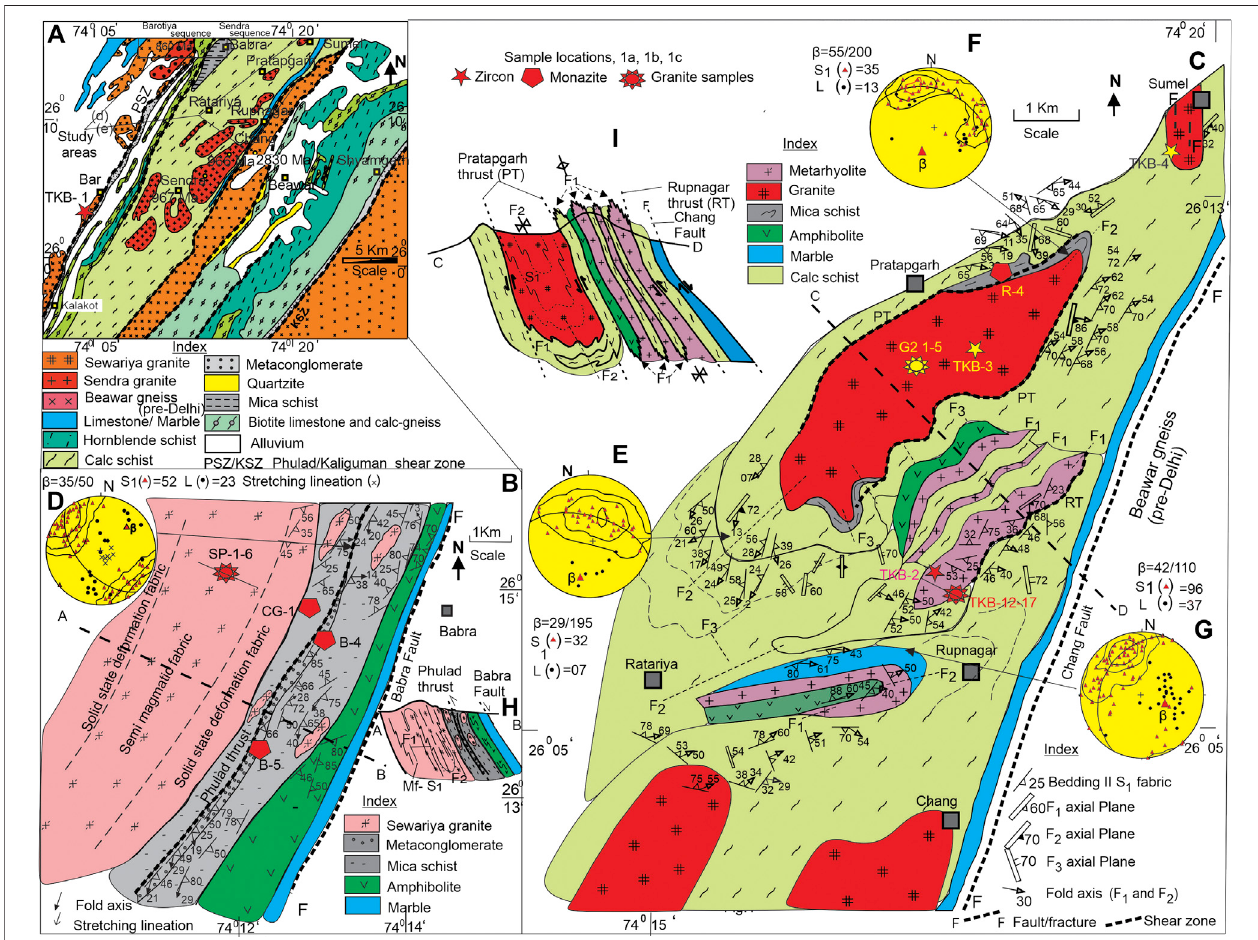
FIGURE2|(A) GeologicalmapoftheSDTaroundBeawar-Rupnagar-Babra;pre-DelhigneissoutcropexposedaroundBeawar,calledBeawargneiss,dividesthe SDT into NW and SE syncline. The study areas (marked by polygons) lie in the NW syncline around Babra and Rupnagar. (B) Geological map of the area west of Babra. (C) Geological map of the area west of Rupnagar. (D – G) Stereoplots of the S 1 fabric, F 1 -F 2 axis, stretching lineation. (H – I) Geological cross sections. Sample locations are marked in the geological map, PT: Pratapgarh thrust, RT: Rupnagar thrust Geological Setting of the Study Area-Present Study.